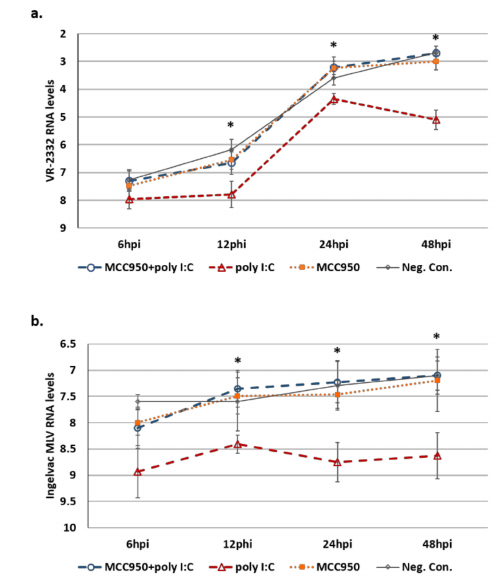
Figure 9. Treatment of PAMs with cell culture supernatants from NLRP3 inflammasome activated PAMs reduces PRRSV replication. PAMs ( n = 3) were treated with the NLRP3 inflammasome